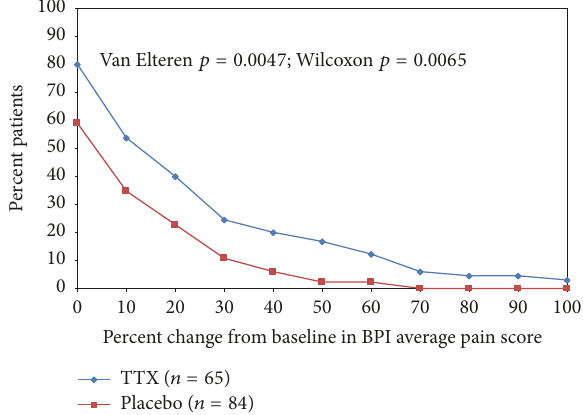
Figure 2: Cancer pain: secondary analyses. % change from baseline average pain (Q5 BPI) Cumulative Proportion of Responders Anal- yses (ITT) at late postinjection period.